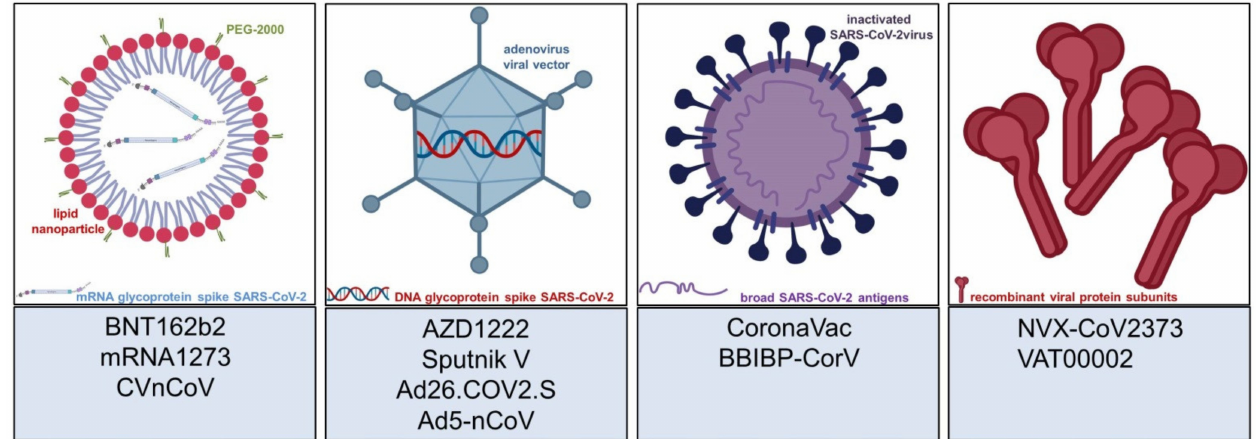
Figure 1. Most commonly used vaccine platforms and selected COVID-19 vaccines. From left to right: mRNA-based vaccines contain genetic information of the spike protein of SARS-CoV-2 in a lipid-nanoparticle-enveloped structure; viral vector vaccines contain DNA of the SARS-CoV-2 spike glycoprotein in a virus other than a coronavirus, most commonly an adenovirus; inactivated coronavirus vaccines contain a multitude of SARS-CoV-2 antigens, and are not limited to the spike glycoprotein; recombinant protein vaccines are specifically engineered molecules to evoke antiviral immunogenicity. Abbreviations: PEG—polyethylene glycol; mRNA—messenger ribonucleic acid; DNA—deoxyribonucleic acid; SARS-CoV- 2—severe acute respiratory syndrome coronavirus